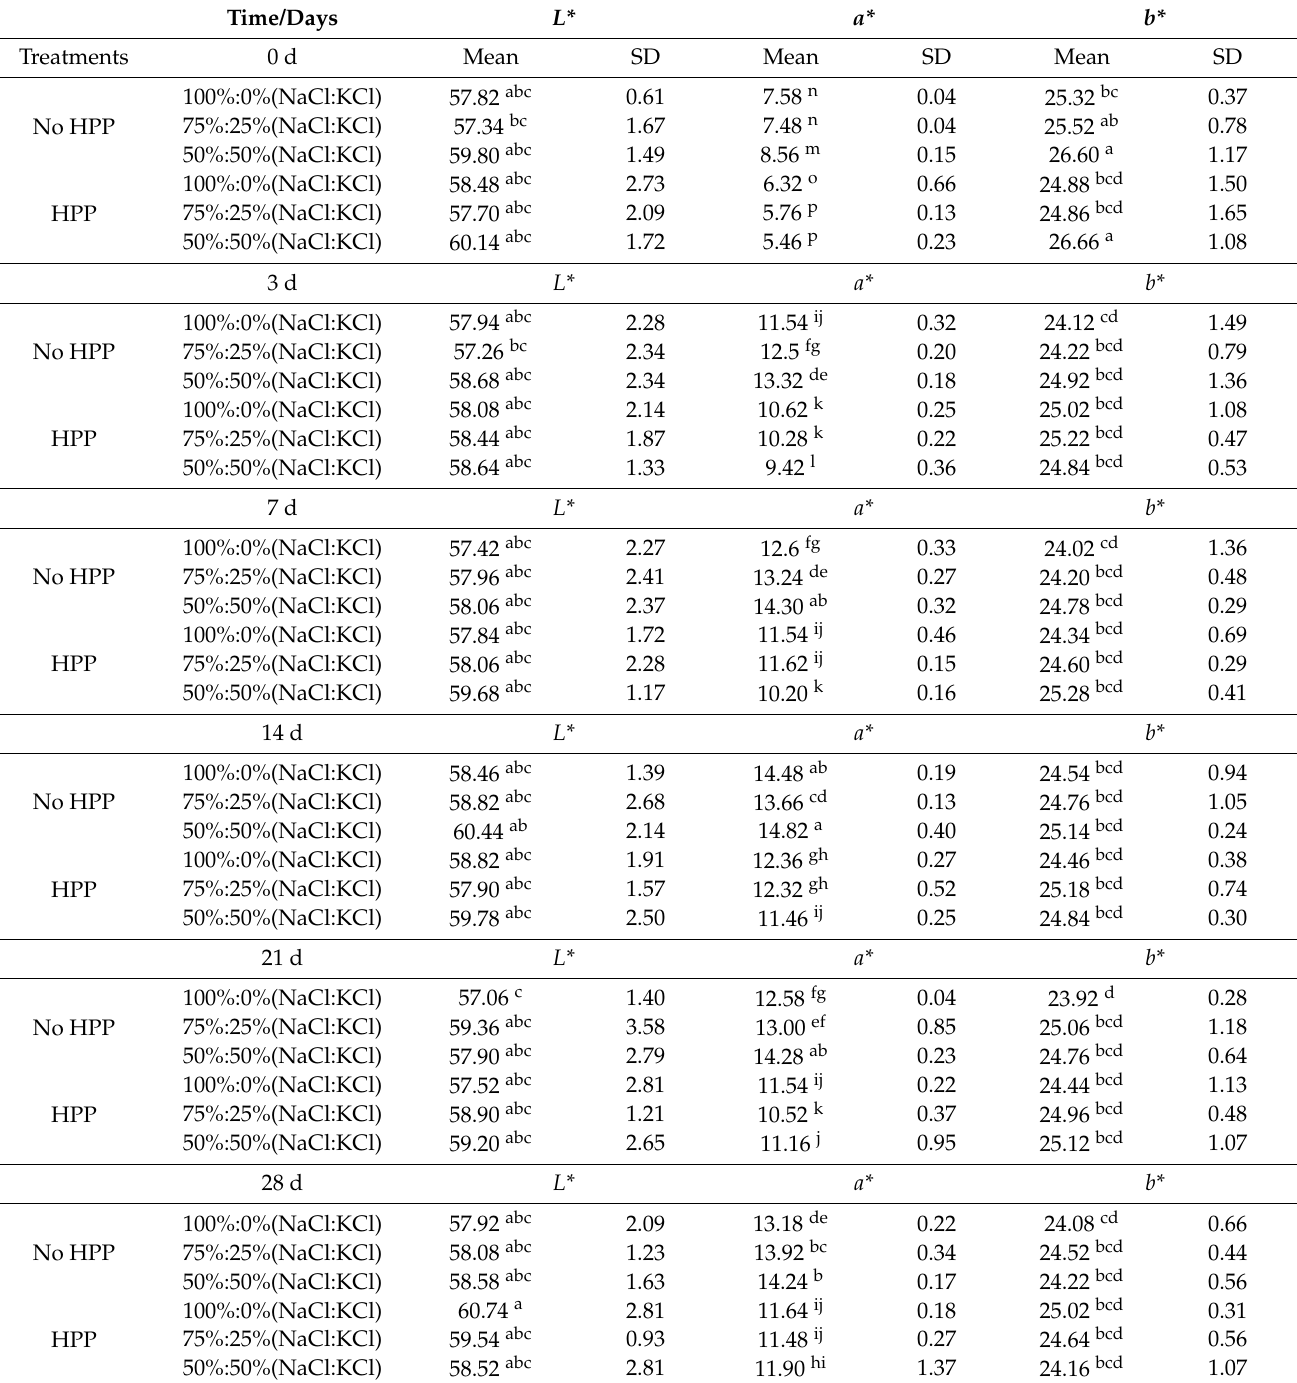
Table 2. Effect of partial substitution of NaCl coupled with HPP at 100 MPa on lightness, redness, and yellowness of beef sausage under different cold storage